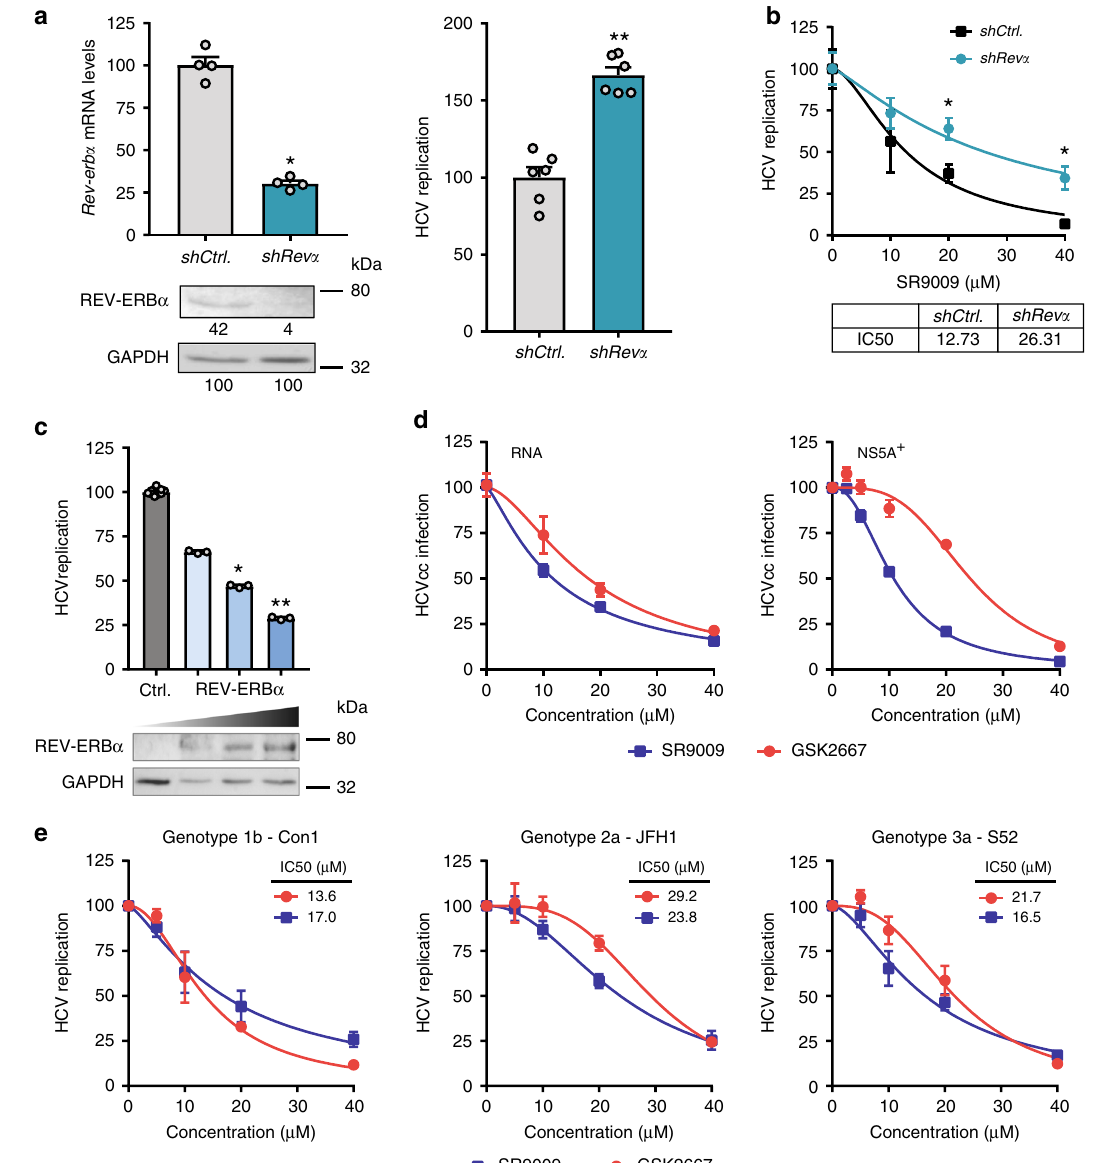
Fig. 3 REV-ERB α inhibits hepatitis C virus (HCV) RNA replication. a Silencing Rev-erb α increases HCV replication. Huh-7 cells supporting a HCV